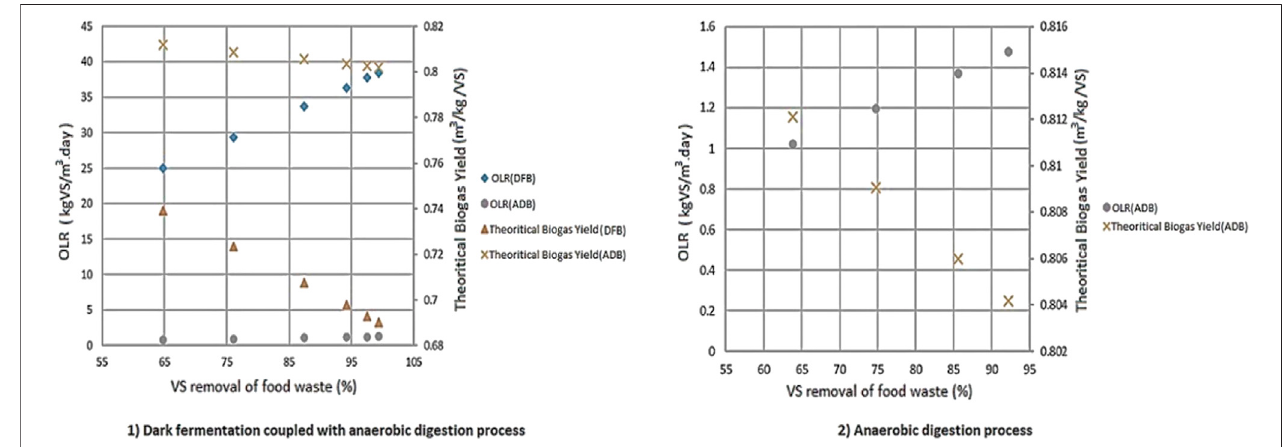
FIGURE 11 | The effects of VS removal on both OLR and theoretical biogas yields for 1) two stage DF coupled with AD and 2) AD-only process.